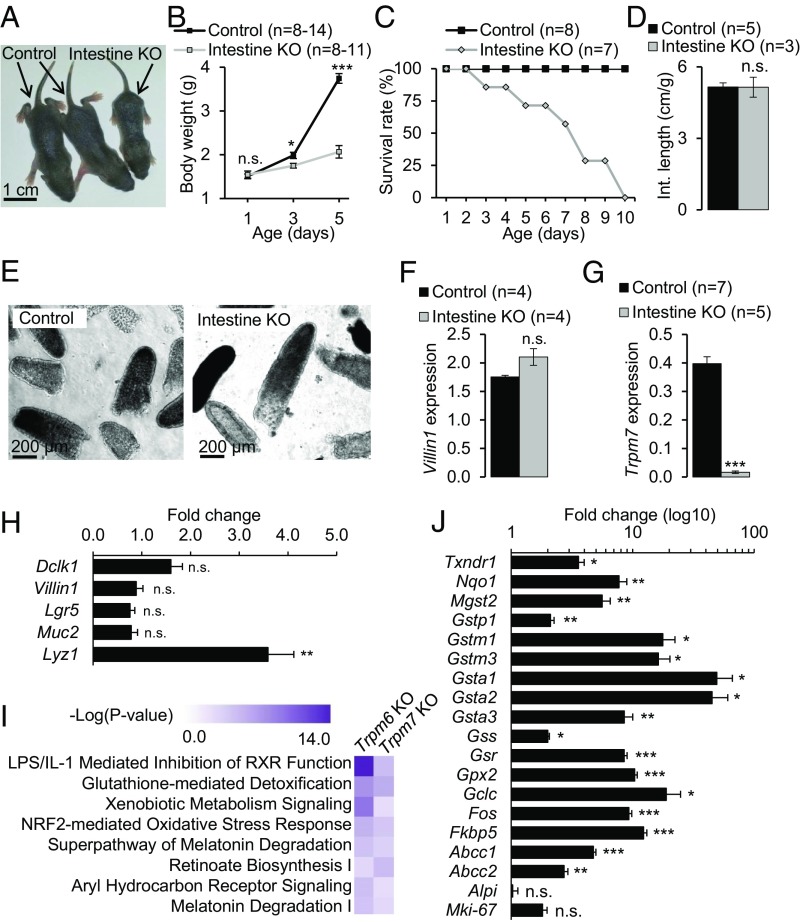
Characterization of mice with intestine-restricted inactivation of Trpm7. (A–D) Trpm7fl/fl (control) and Trpm7fl/fl;Villin1-Cre (intestine KO) littermates were studied for overall physical appearance at P5 (A) and growth (B), survival rate (C), and total length of the intestine normalized to body weight at P5 (D). The results in B and D are represented as mean ± SEM. (E–H) Assessment of Villin1-Cre–mediated deletion of WT Trpm7 transcripts in the intestine of Trpm7fl/fl;Villin1-Cre mice. (E) Representative images of purified villi isolated from the whole intestine of P5 littermates. (F and G) Relative expression levels (mean ± SEM) of Villin1 (F) and Trpm7 (G) in mRNA extracts from villi examined by qPCR using Hprt as a reference transcript. (H) Relative expression levels of Dclk1, Villin1, Lgr5, Muc2, and Lyz1 in mRNA extracts from the whole duodenum analyzed by qPCR using Hprt as a reference transcript. Results are shown as fold change (mean ± SEM) in Trpm7fl/fl;Villin1-Cre (n = 8) mice vs. Trpm7fl/fl (n = 7) mice. (I) Pathways commonly affected in the intestine of Trpm7-deficient mice and the liver of Trpm6-deficient mice (13). Whole-genome profiling of the transcriptome of villi isolated from P5 Trpm7fl/fl;Villin1-Cre (n = 3) and Trpm7fl/fl (n = 3) littermates was analyzed using ingenuity pathway analysis (IPA) (Datasets S1 and S2). Next, IPA was used to compare gene networks highly affected in Trpm7fl/fl;Villin1-Cre (Trpm7 KO) and Trpm6 null (Trpm6 KO) mice (13). (J) Relative expression levels of markers of mature and progenitor enterocytes Alpi and Mki-67 and genes representing the IPA glutathione-mediated detoxification and the NRF2-mediated oxidative stress response (Dataset S2) were examined in mRNA extracts from villi of P5 littermates using qPCR, using Hprt as a reference transcript (n = 3 mice per genotype). The results are shown as fold change (mean ± SEM) in Trpm7fl/fl;Villin1-Cre samples vs. Trpm7fl/fl samples. ***P ≤ 0.001; **P ≤ 0.01; *P ≤ 0.05; n.s., not significant (Student’s t test).